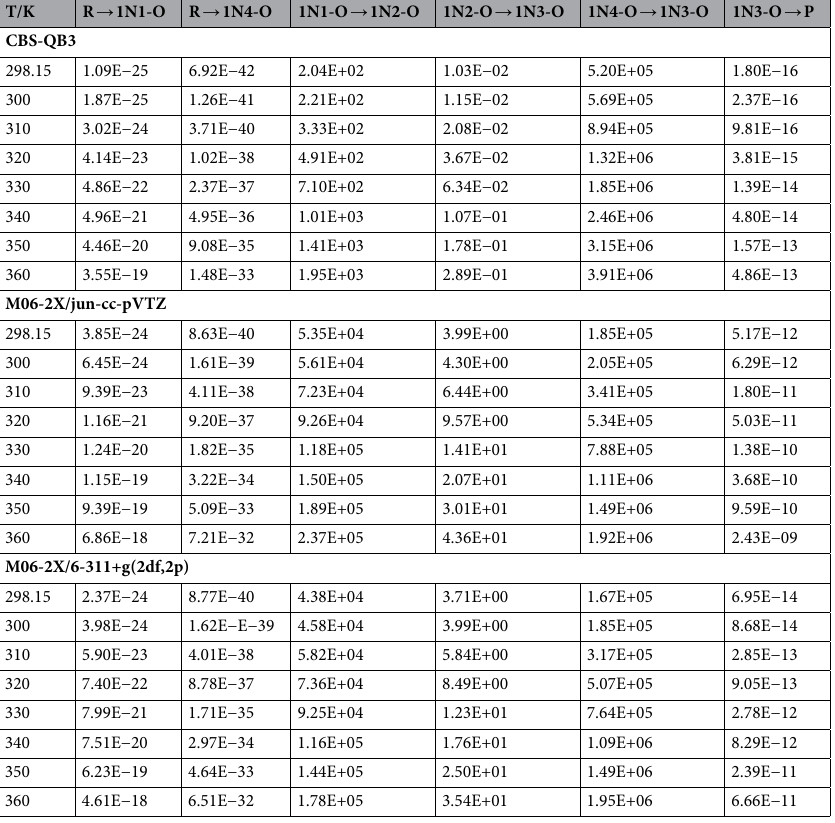
Table 5. Unimolecular rate constants (s −1 ) calculated by RRKM theory at the CBS-QB3, M06-2X/Jun-cc- pVTZ, and M06-2X/6-311+g(2df,2p) levels for all channels of 1,4-H shift of